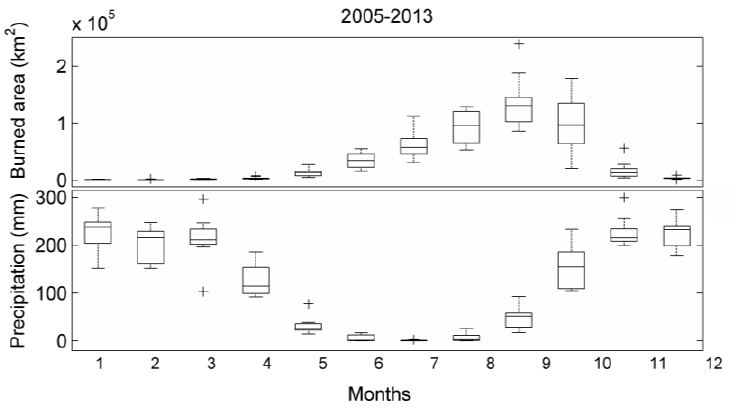
Figure 9. Boxplots of monthly values of BA ( upper panel ) and precipitation ( lower panel ) for 2005–2013. On each box, the central mark is the median, the edges of the box are the 25th and 75th percentiles and the whiskers delimit the extreme values.